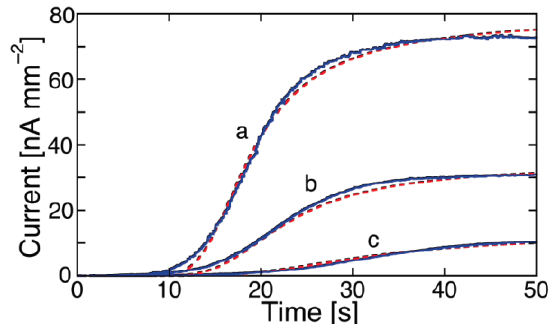
Figure 1. The solid curves are three successive current-time curves on the same bilayer lipid membranes (BLM) following transmembrane potential steps from 0 to −60 mV (a), −55 mV (b) and −50 mV (c), in aqueous 0.1 M KCl containing 0.625 μM monazomycin [29]. The corresponding dashed curves were calculated by the nucleation-and-growth model outlined in the text using the parameters θ 0 = 0.1, n = 2, and k h , N v h , R 2 = 0.016 s −3 for all three curves; p and k N k R 2 were given the values: (a) 1 and 15 s −3 ; (b) 0.438 and 130 s −3 ; (c) 0.163 and 1250 s −3 . The three calculated currents were matched to the experimental ones by multiplying them by the same factor 80. (Reprinted with permission from [30]. Copyright 2007, American Chemical Society).